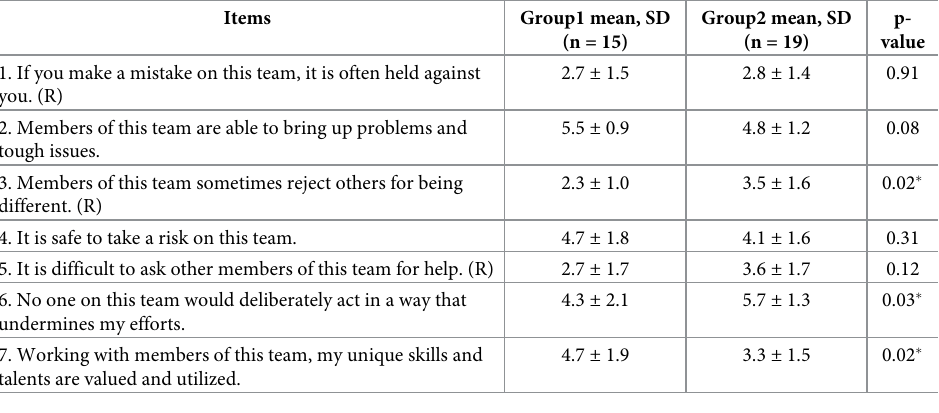
Items Group1 mean, SD